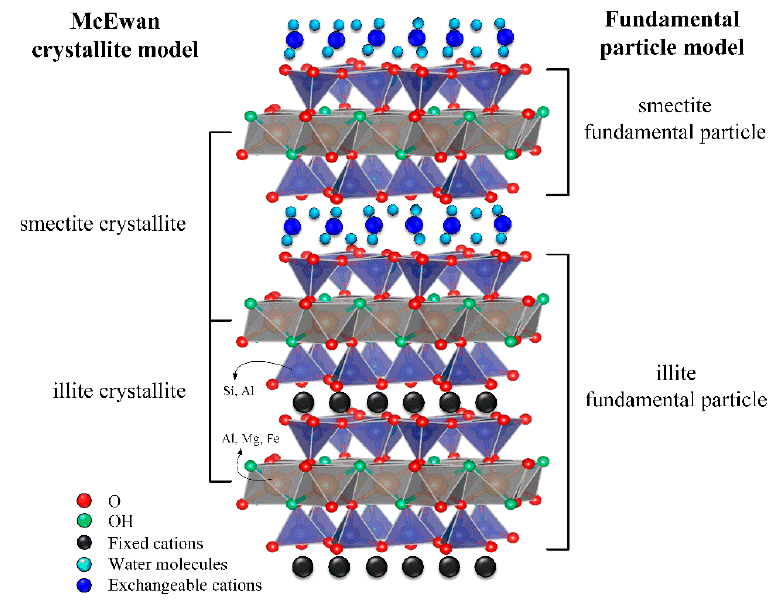
Figure 1. Structure models of I-S described by McEwan crystallite and fundamental particles.